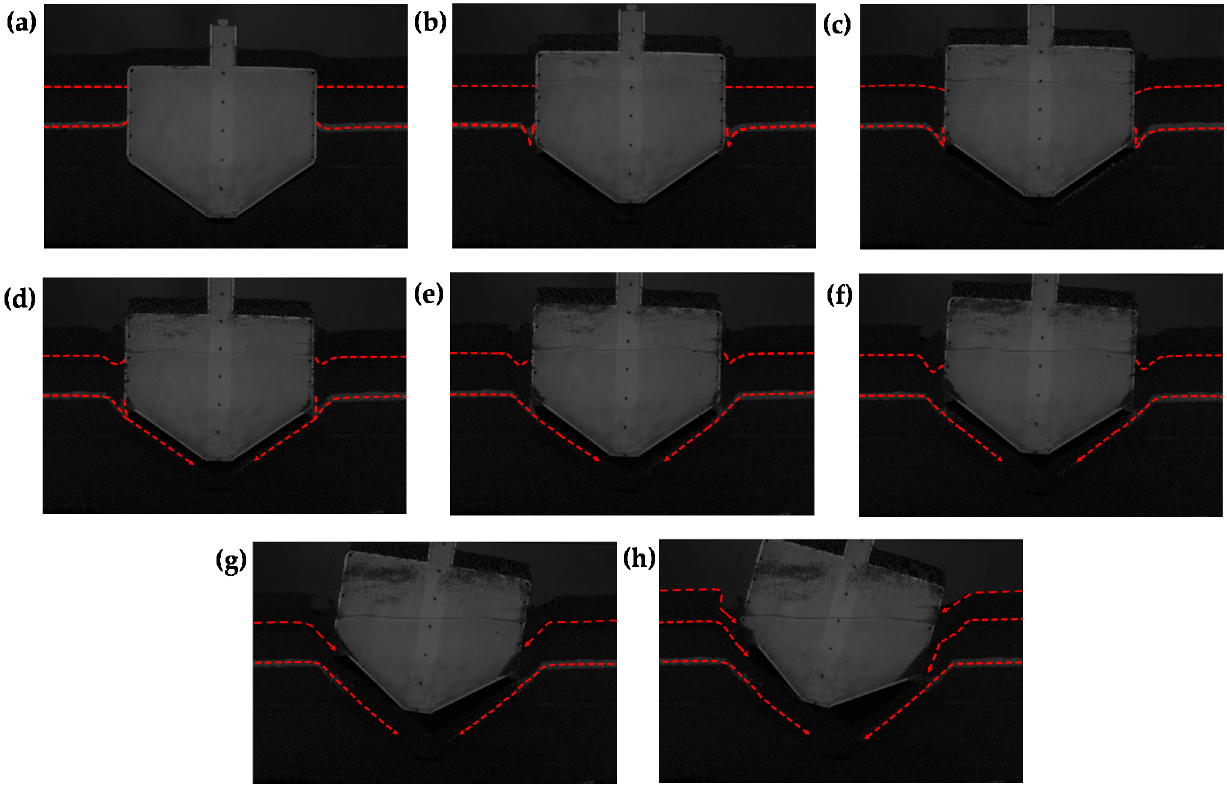
Figure 11. Characteristic diagram of silo displacement and soil deformation at different stages: ( a ) Time 1; ( b ) Time 2; ( c ) Table 3; ( d ) Time 4; ( e ) Time 5; ( f ) Time 6; ( g ) Time 7; ( h ) Time 8.